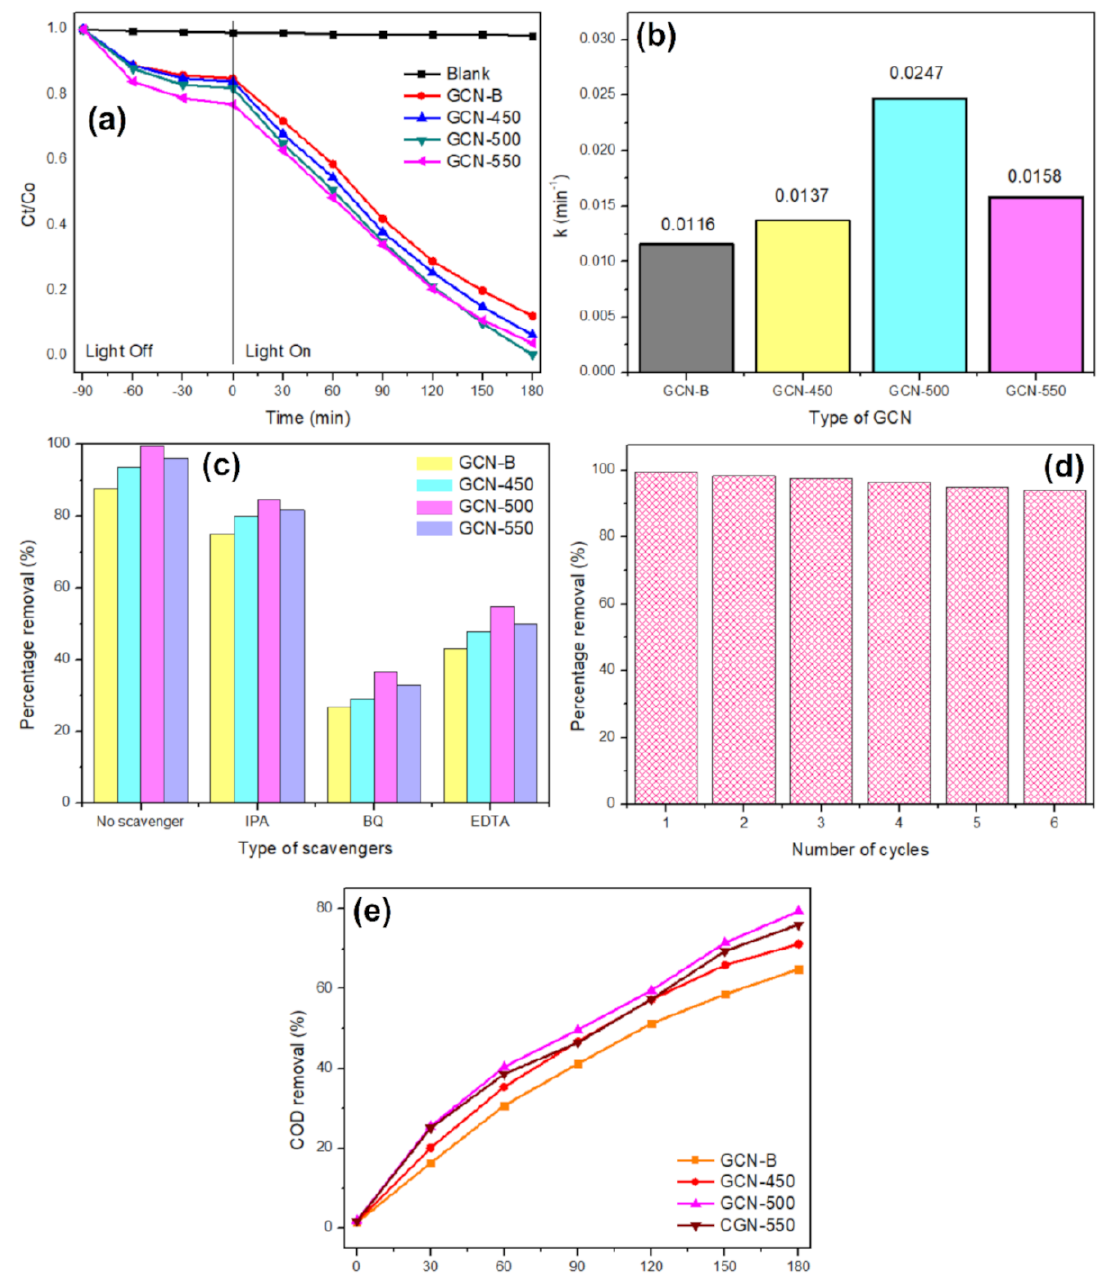
Figure 10. ( a ) The photocatalytic performance of TC with GCN samples under irradiation of visible light ( λ > 420 nm), ( b ) the kinetics for TC photodegradation with different GCN samples, ( c ) trapping experiment of active species during the TC photodegradation, ( d ) six recycling GCN-500 experiments for TC photodegradation, and ( e ) The COD removals of TC with all GCN